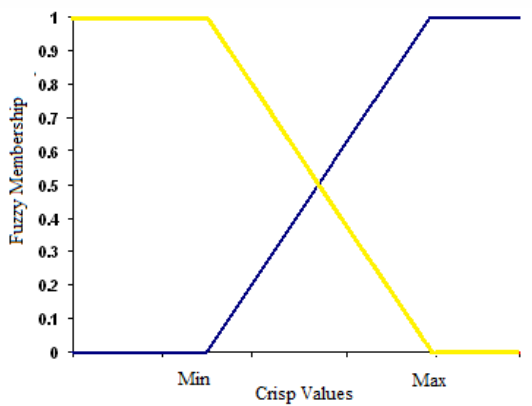
Figure 6. Linear fuzzy membership functions with positive (blue) and negative (yellow) slopes used in the fuzzification step.